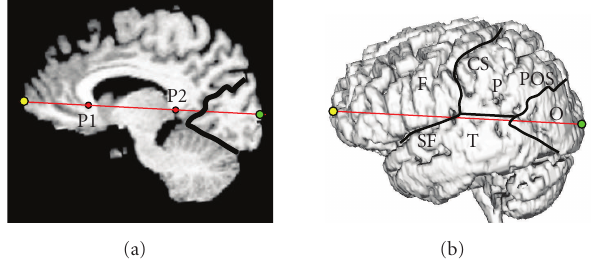
Figure 1: Definition of the four brain lobes (F,P,T,O) on the lateral cortical surface based on user-defined landmarks such as the central sulcus (CS), Sylvian fissure (SF), and the parieto-occipital sulcus (POS). The locations of the frontal (yellow) and occipital (green) poles are obtained as the extension of the AC-PC line to the front and back of the brain. The horns of the corpus callosum (P1 and P2) as well as the POS are defined in the medial